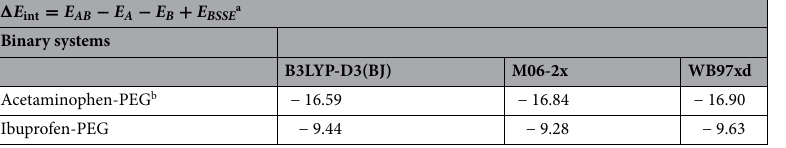
Table 4. The energy difference ( Δ E int ) of binary systems for the three functional methods. a The E AB indicate the energy of binary systems, The E A demonstrative of the energy of Drugs and The E B demonstrative of the PEG energy in the mentioned systems. b Ace = Acetaminophen, Ibo = Iboprophen, PEG = Poly ethylene glycol.